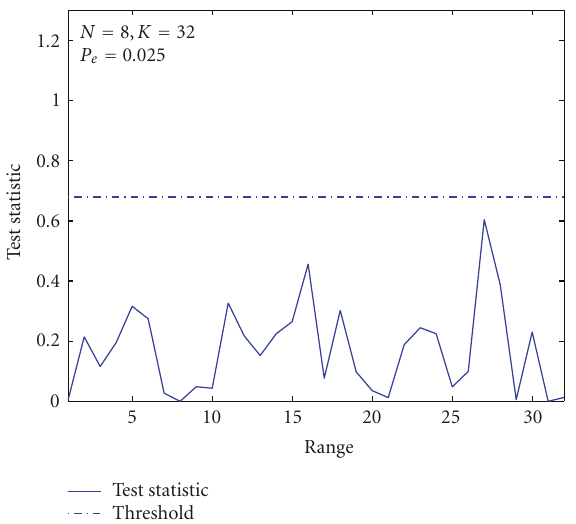
Figure 4: Test statistic versus range in K -distributed homogeneous clutter, where ν = 0 . 1, μ = 1, N = 64, K = 256, N it = 1, and P e = 0 . 01.